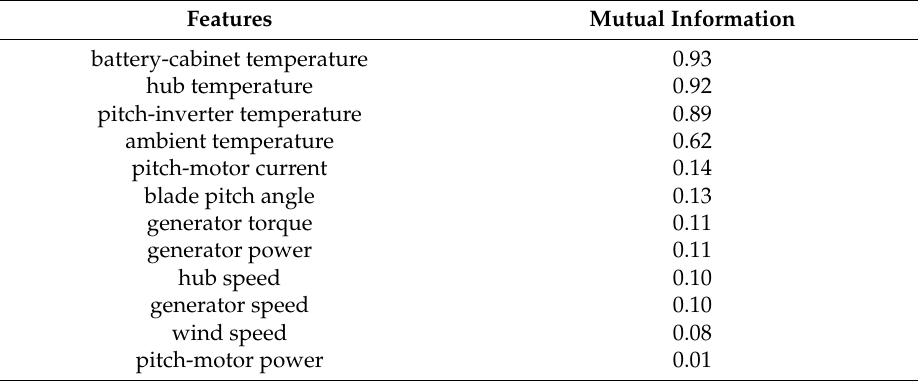
Table 4. Mutual information between the parameters and the pitch-motor